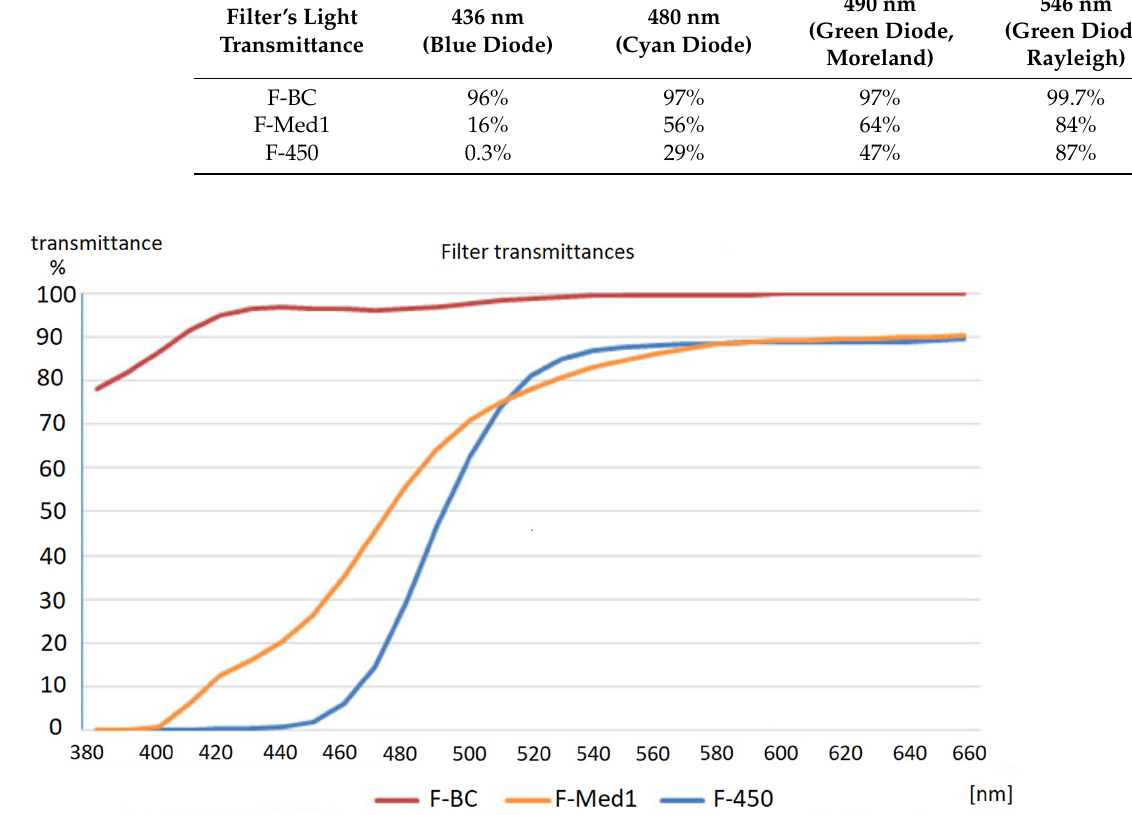
Table 1. Transmittance of filters used in the study in relation to wavelengths emitted by anomalo- scope diodes. Filter’s Light